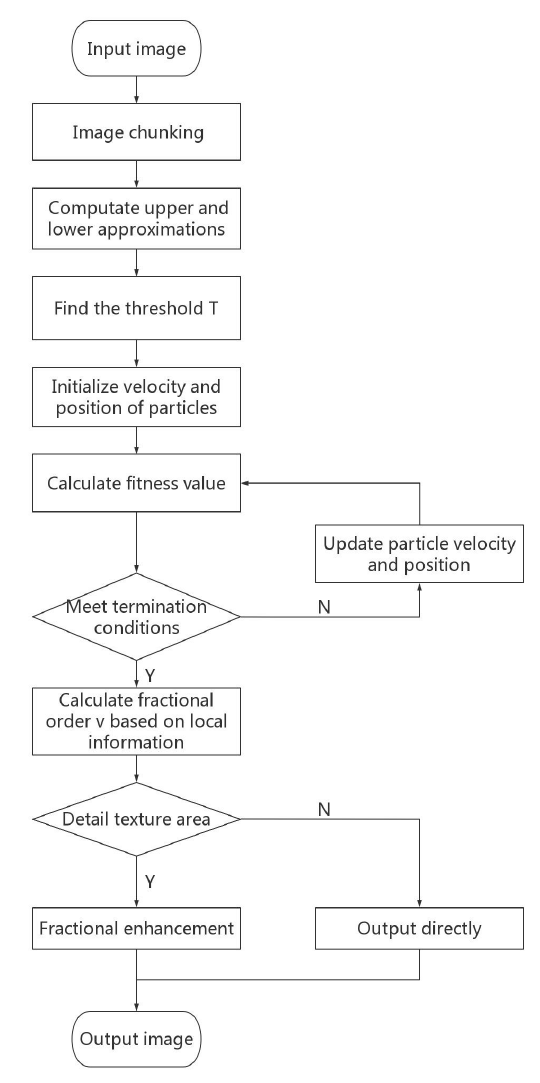
Figure 3. The algorithm flow chart of the